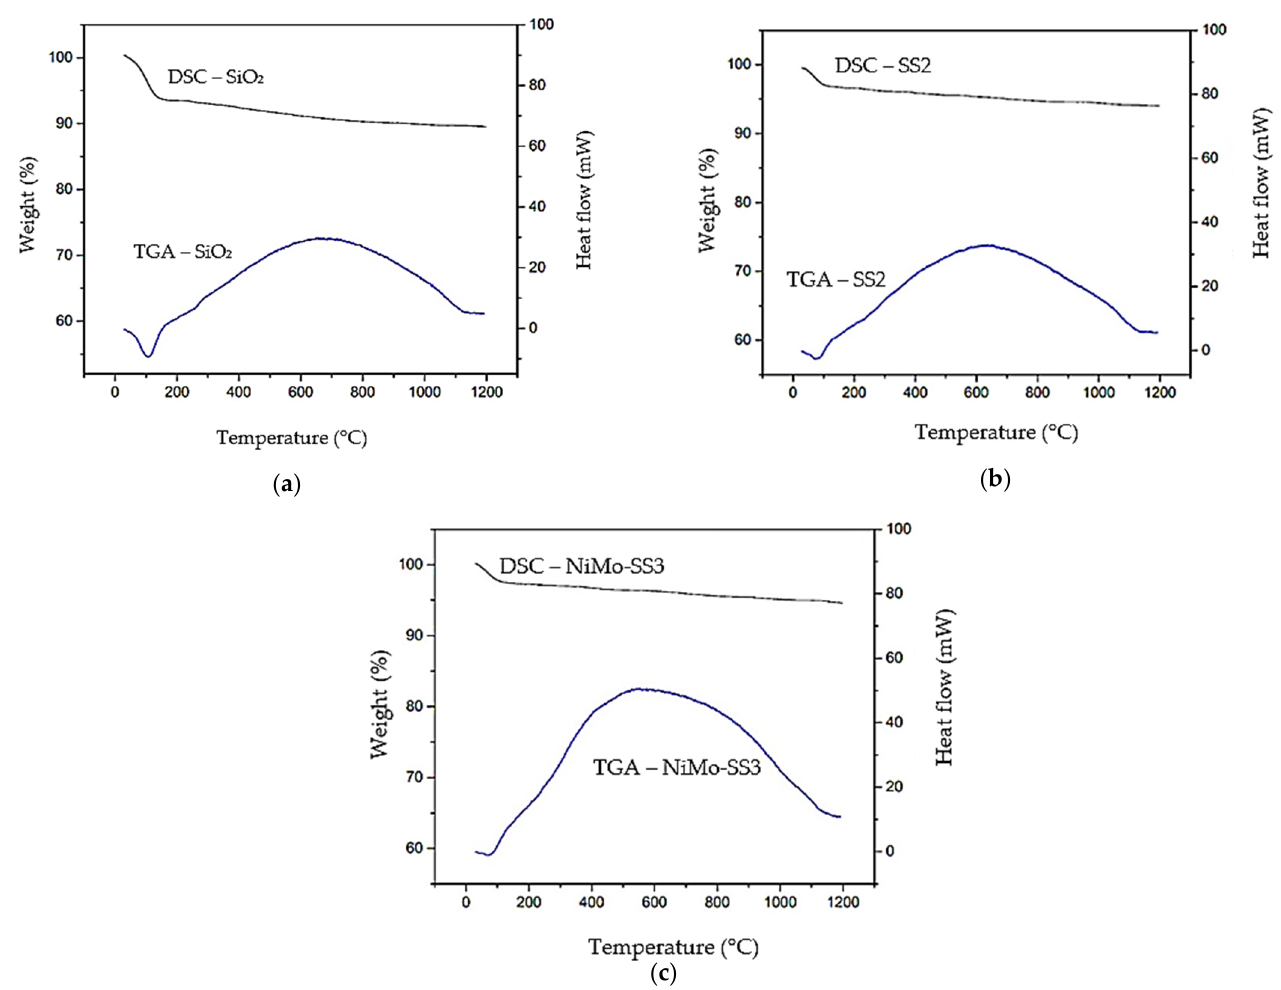
Figure 6. TG/DSC thermograms of ( a ) SiO 2 , ( b ) SS2, and ( c ) NiMo-SS3 catalysts.